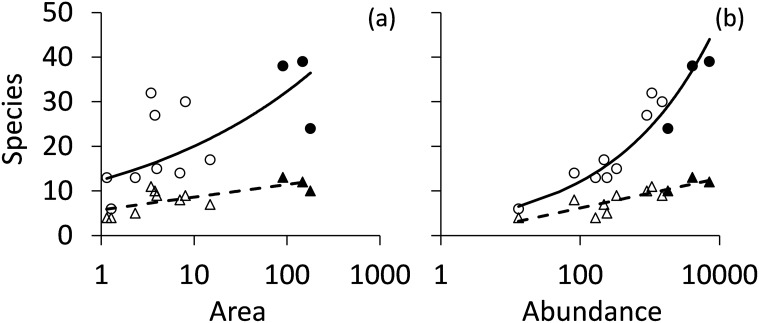
Species—area (a) and species—abundance (b) relationships of all species (circles) and of forest specialist species (triangles) of the East African Taita forest fragments.Power function ordinary least squares regressions to all species: a: S = 12.4A0.21, r2 = 0.44, P < 0.01; b: S = 3.03 I0.30, r2 = 0.92, P < 0.001. Logarithmic regression to specialist species a: S = 1.23 ln A + 5.78, r2 = 0.53, P < 0.01; b: S = 1.45 ln I– 0.49, r2 = 0.73, P < 0.01.